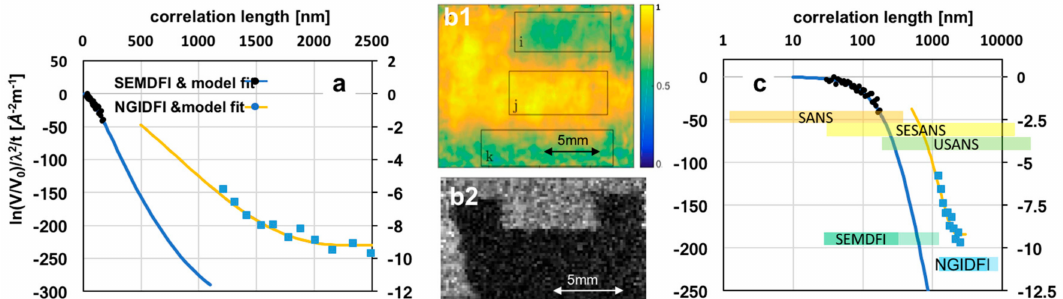
Figure 7. Resolution ranges and limitations correlation length and direct real space resolution for different DFI approaches; ( a ) modelled data from wavelength dispersive NGI-DFI and time-of-flight (ToF) SEM-DFI; ( b1 ) real space image of the SEM-DFI [34] and ( b2 ) of ToF NGI-DFI; ( c ) curves from ( a ) on logarithmic correlation length scale and including ranges of different neutron techniques to explore the corresponding size ranges (note these apply only to the size range, i.e.,